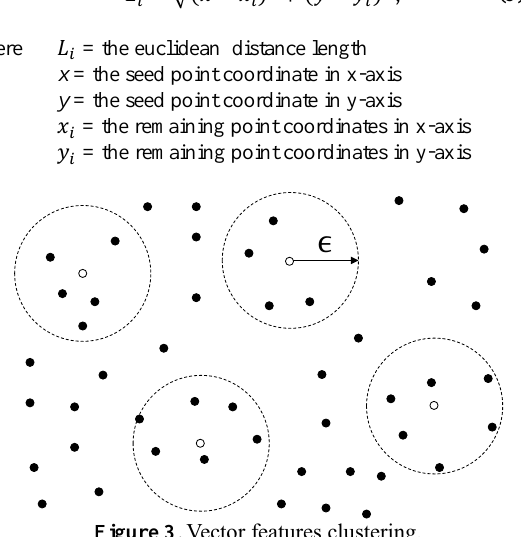
Figure 3 . Vector features